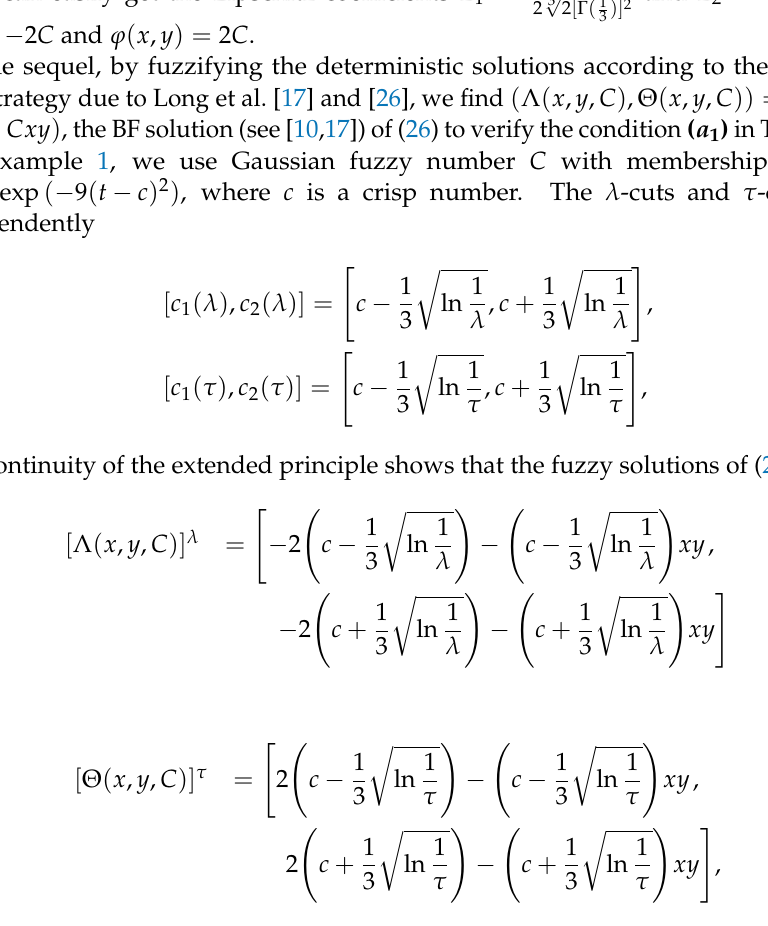
(cid:20) (cid:21) (cid:113) (cid:113) 1 − 1 ln 1 ,1 + 1 ln 1 and [ C ] τ = 3 3 λ λ